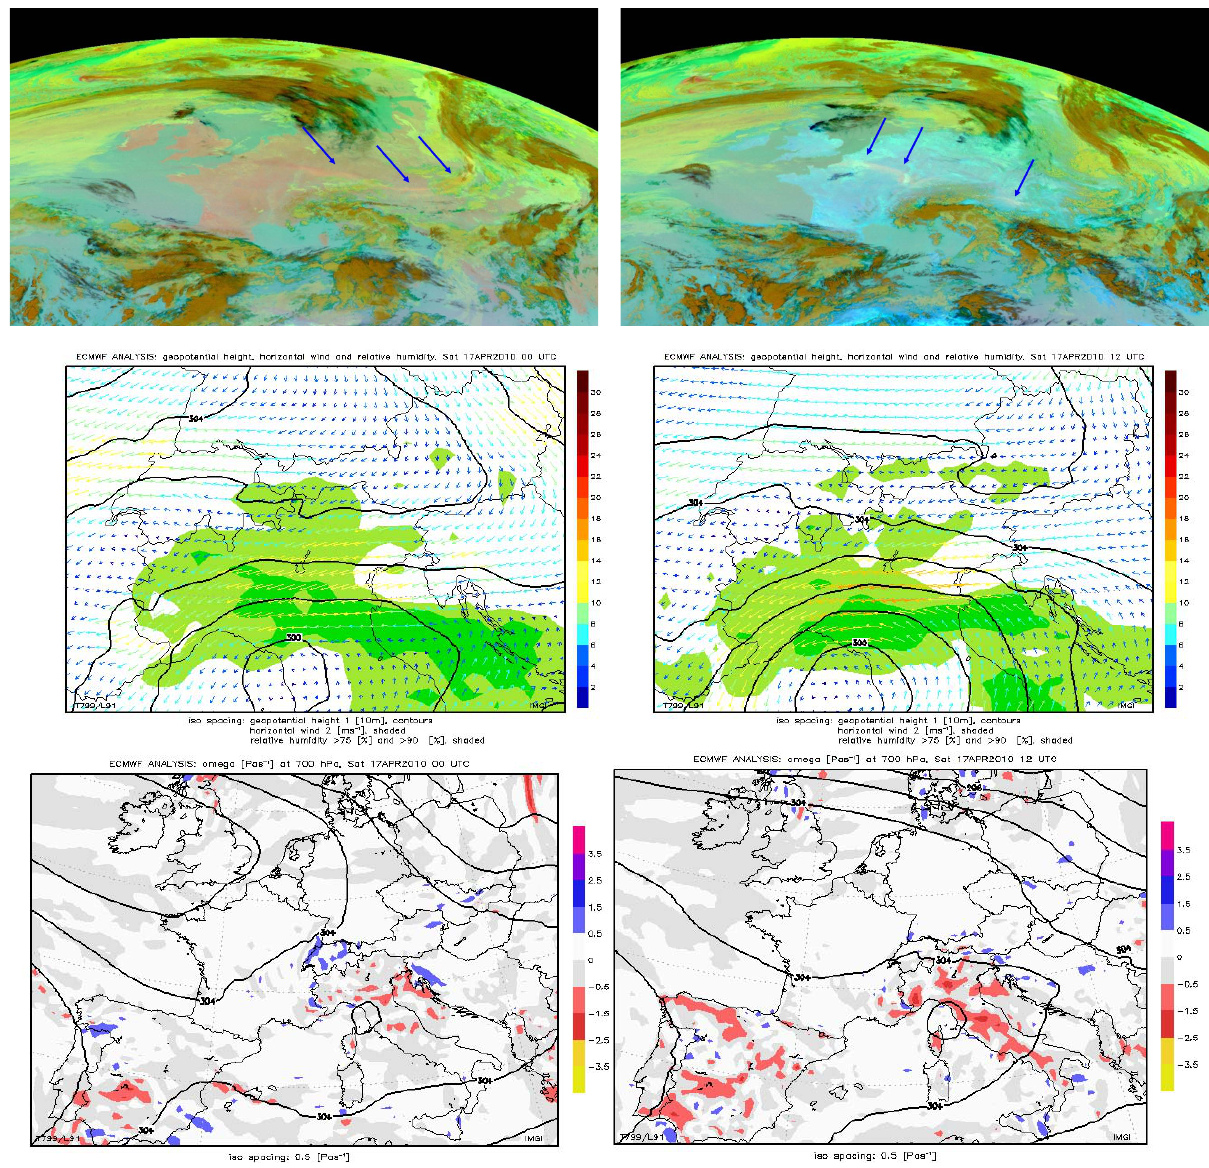
Fig. 3. Upper panels: METEOSAT SEVIRI “ash product” from 17 April, 00:00 UTC (left) and 17 April, 12:00UTC (right). Blue arrows indicate the volcanic plume which is colour-coded in orange. High cloudiness (brownish) is apparent south of the Alps allocated to a cyclonic system over the Gulf of Genoa. Middle panels: 700 hPa geopotential height (10gpm contour lines), relative humidity ( > 90% in dark green) and horizontal wind (speed and direction, colour coded arrows in 2ms − 1 steps) taken from ECMWF analyses. Lower panels: 700hPa geopotential height (40gpm contour lines) and vertical wind components (colour coded in steps of 0.5Pas − 1 )